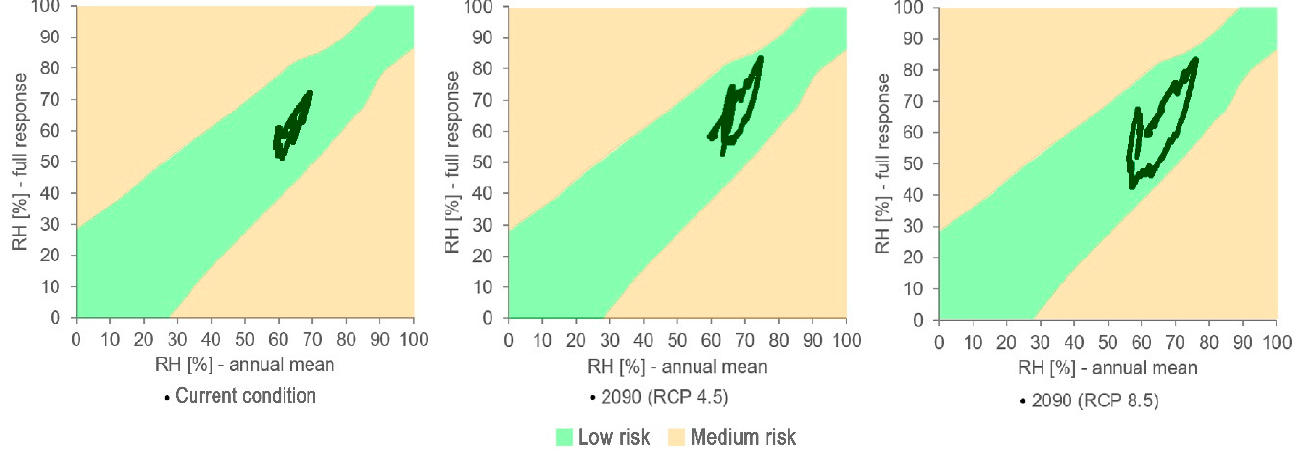
Figure 17. Risks associated with mechanical deterioration on lacquered wood furniture for climate change scenarios.